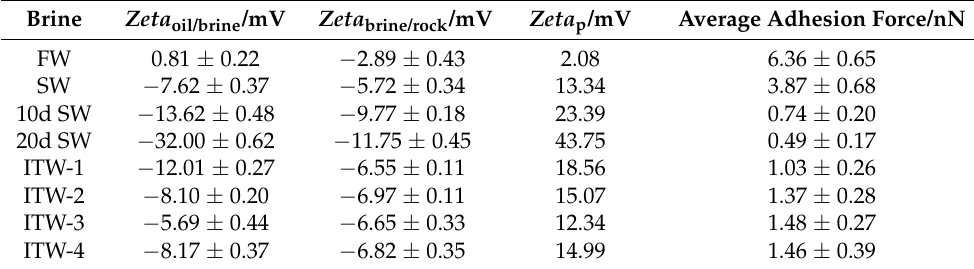
Table 5. Zeta potential of fluid–fluid and fluid–rock, Zeta p , and average adhesion force.